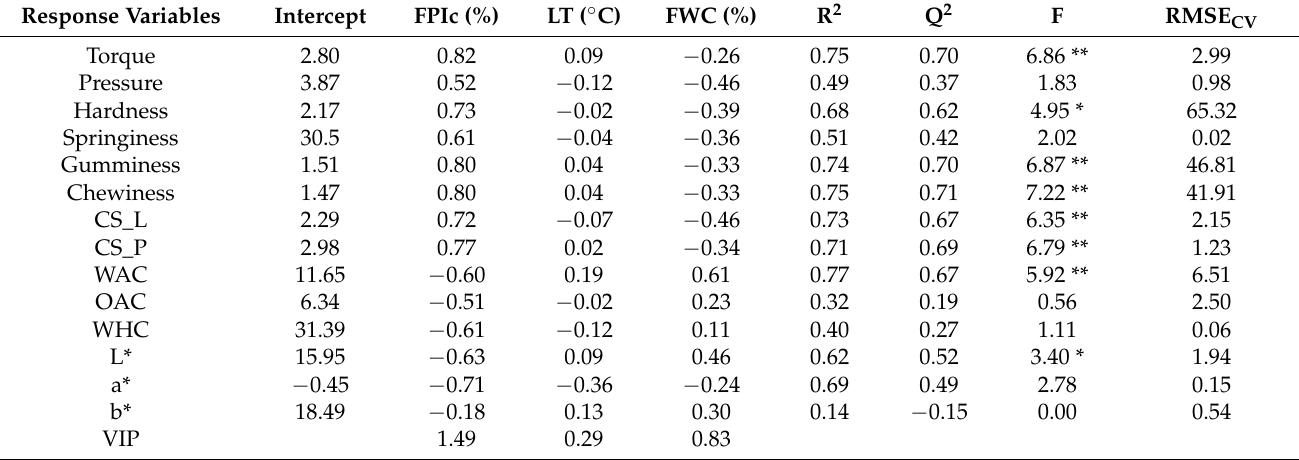
Table A1. Results from the PLSR analysis showing the regression coefficients of the independent variables of faba bean protein isolate content (FPIc), feed water content (FWC), and temperature of the long cooling die (LT) on the response variables of torque, pressure, hardness, springiness, gumminess, chewiness, cutting strength longitudinal (CS_L), cutting strength perpendicular (CS_P), water absorption capacity (WAC), oil absorption capacity (OAC), water hydration capacity (WHC), and colour parameters of L*, a*, and b*, including the coefficient of correlation (R 2 ), predictive